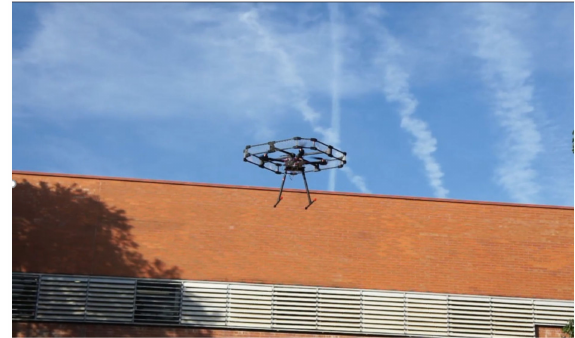
Figure 8. Prototype UAV platform developed during controlled flight tests.